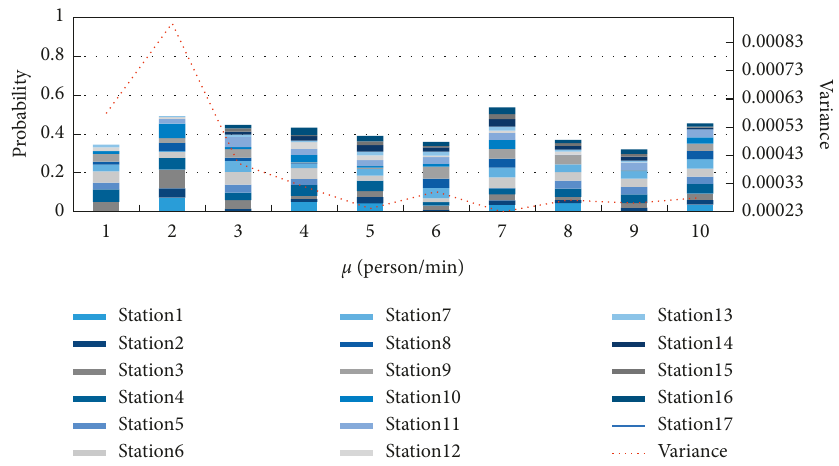
Figure 4: Probability and variance of bus headways in the bunching state for different μ .